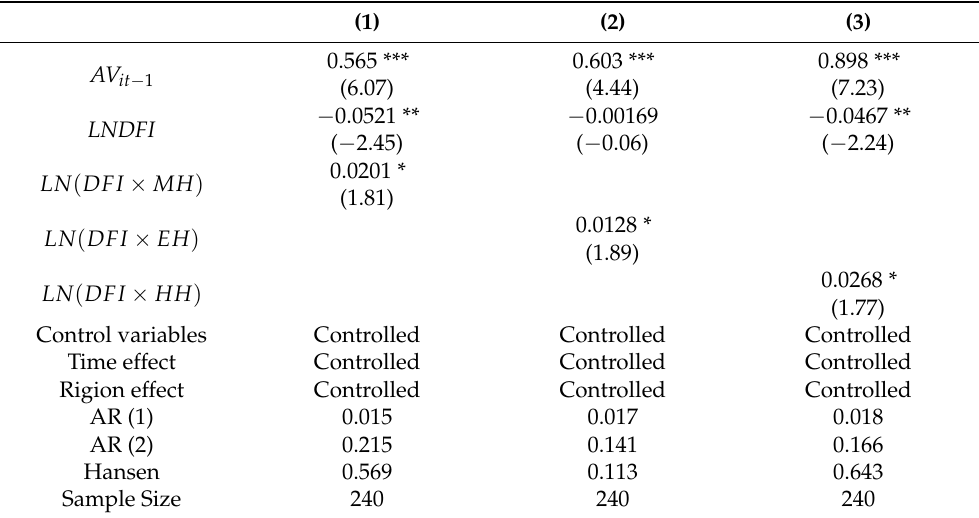
Table 8. Interactive effects of rural human capital and digital inclusive